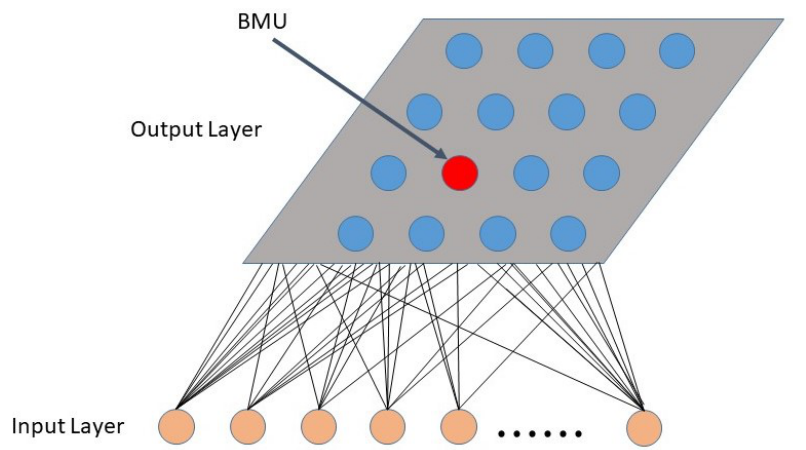
Figure 3. Self-organizing mapping